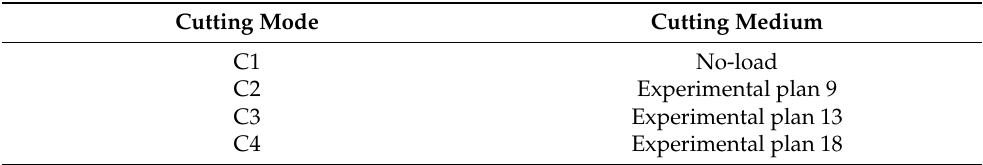
Table 8. The corresponding situation of cutting mode.